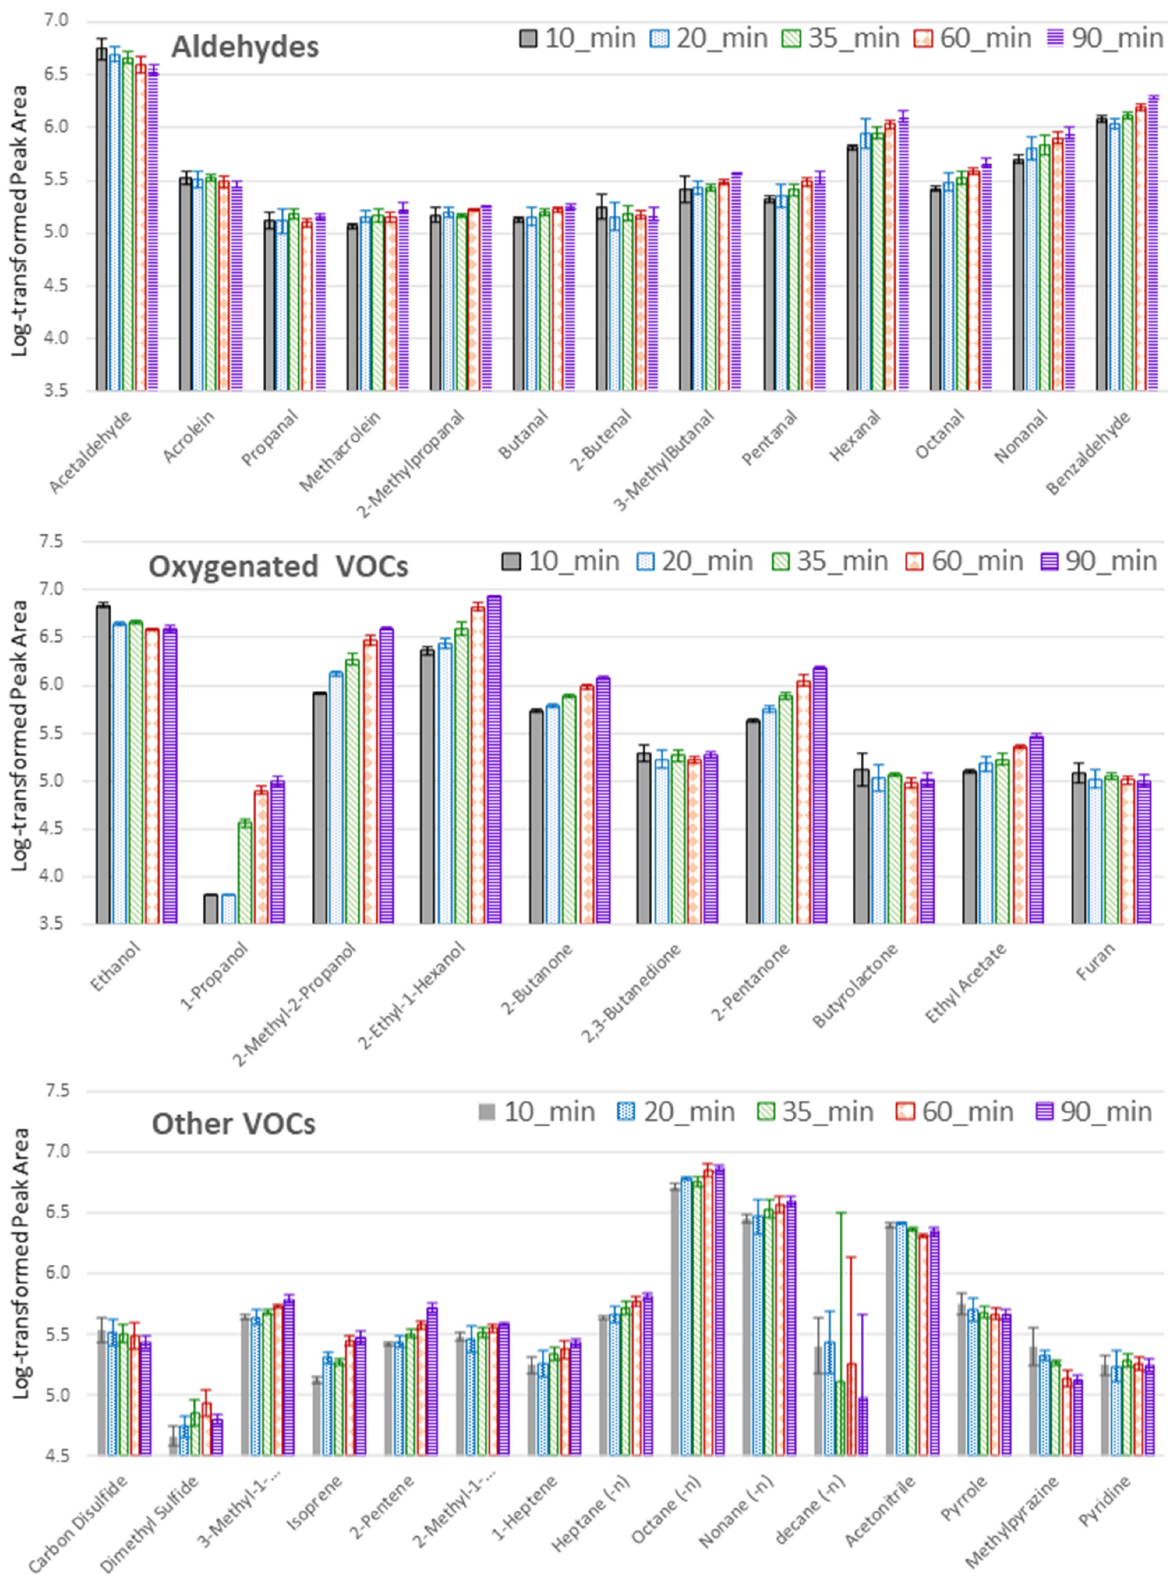
Figure 4. Optimization of extraction time. The y -axis represents log-transformed peak area values, where means are given with a respective standard deviation for three replicates ( n = 3) for each extraction time: 10min (grey boxes), 20min (blue boxes), 35min (green boxes), 60 min (red boxes), 90 min (magenta boxes).